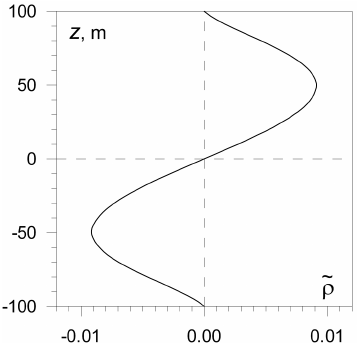
Figure 3. Stable solution for case 1 and boundary condi- = 2, K = ) = 0 . 5 (ks/K) 1 / 2 H 2 tions of type 2 for χ = Re( − aH 2 0 0 10 − 5 m 2 s − 1 , H 0 = 100m, and s = 10 − 7 m − 1 s − 1